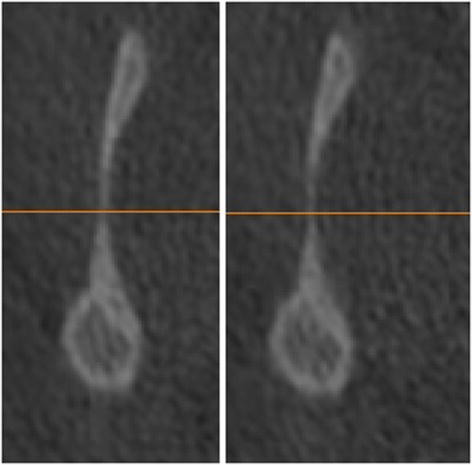
The inferior limit is selected when the sigmoid area disappears.